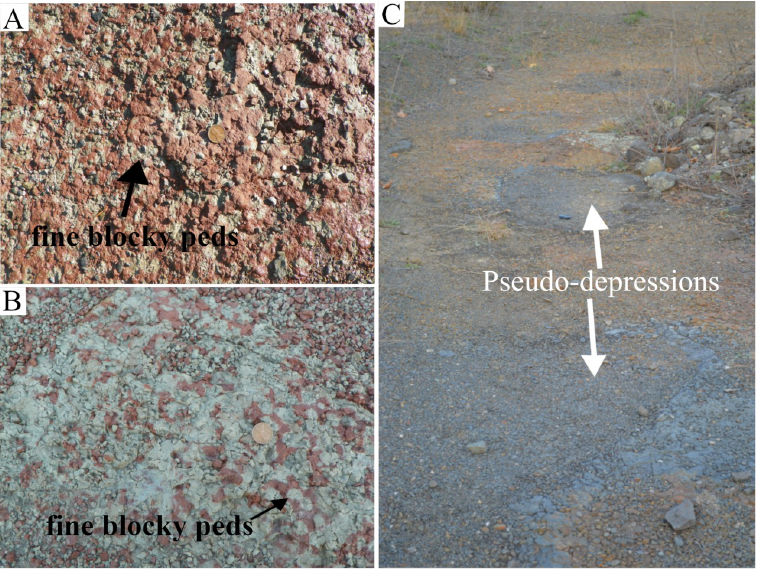
Fig 15. Some main features of paleosol along the E-F section, and surrounding areas. Figures (A) and (B) show granular peds of similar sizes. Note that in figure (A) weak-red peds make the matrix and in figure (B), the light-olive green peds make the matrix of the paleosol. (C) The area between section E-F and G-H shows a linear distribution of the pseudo-depressions that mark the edge of the local-depression.